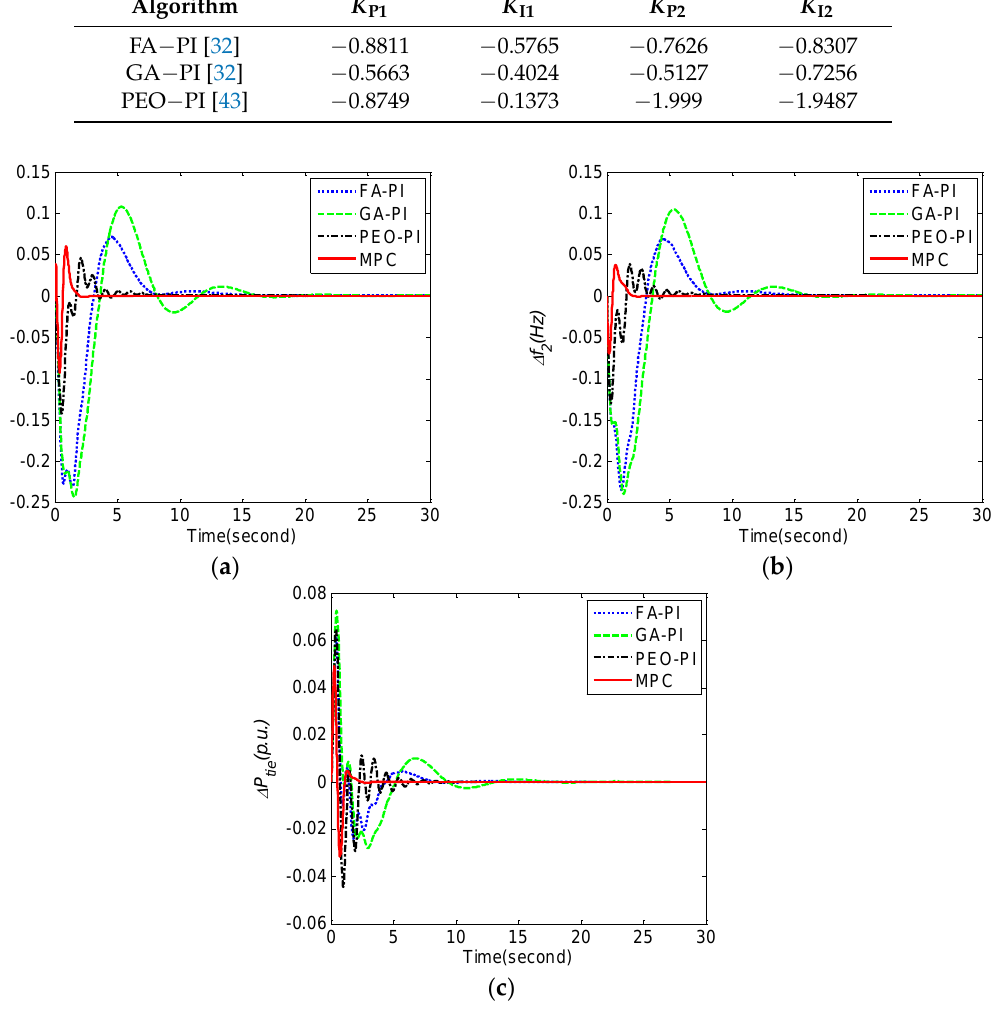
Figure 4. Comparison of frequency deviations ∆ f 1 , ∆ f 2 , and tie line power deviation ∆ P tie obtained by different control methods for case 1. ( a ) frequency deviation ∆ f 1 ;( b ) frequency deviation ∆ f 2 ; ( c ) tie line power deviation ∆ P tie .